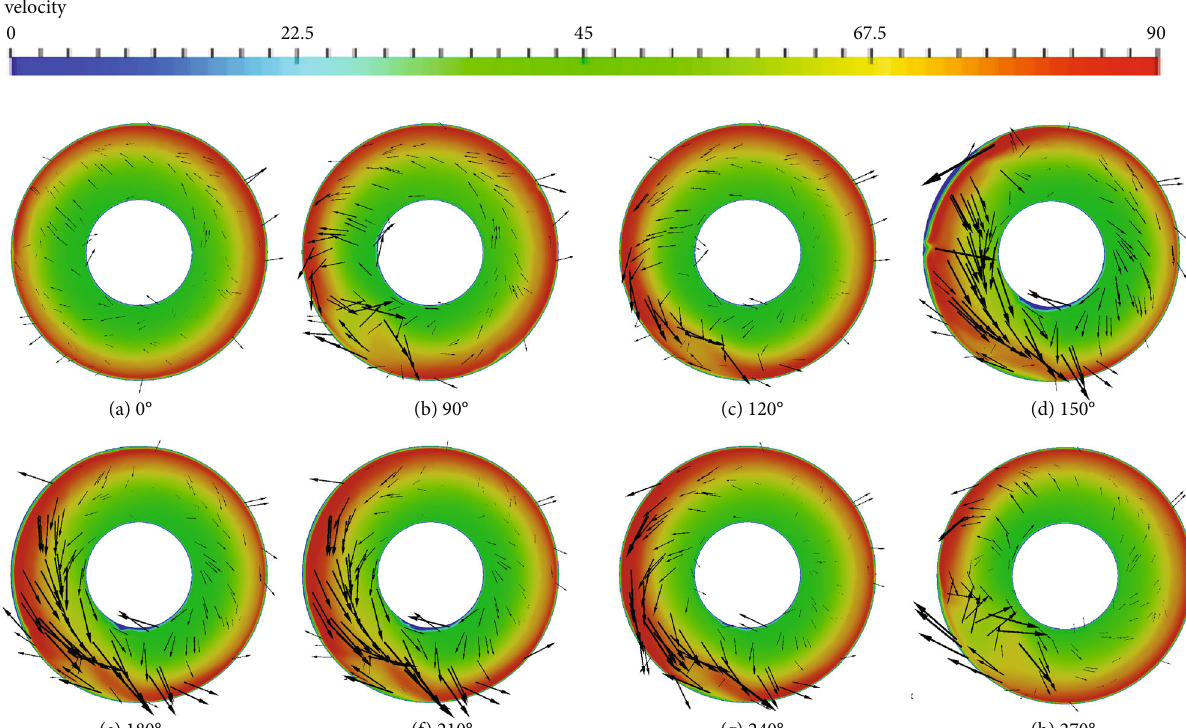
Figure 16: In fl ow contour with velocity vector with respect to crosswind